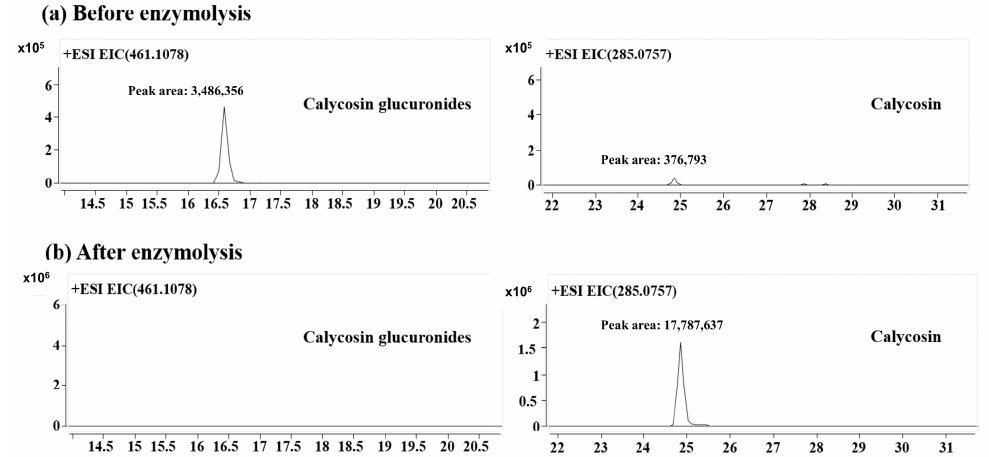
Figure 1. HPLC-Q-TOF-extracted ion chromatograms (EICs) and peak areas of calycosin glucuronides and calycosin in plasma samples before ( a ) and after ( b ) β -glucuronidase treatment.